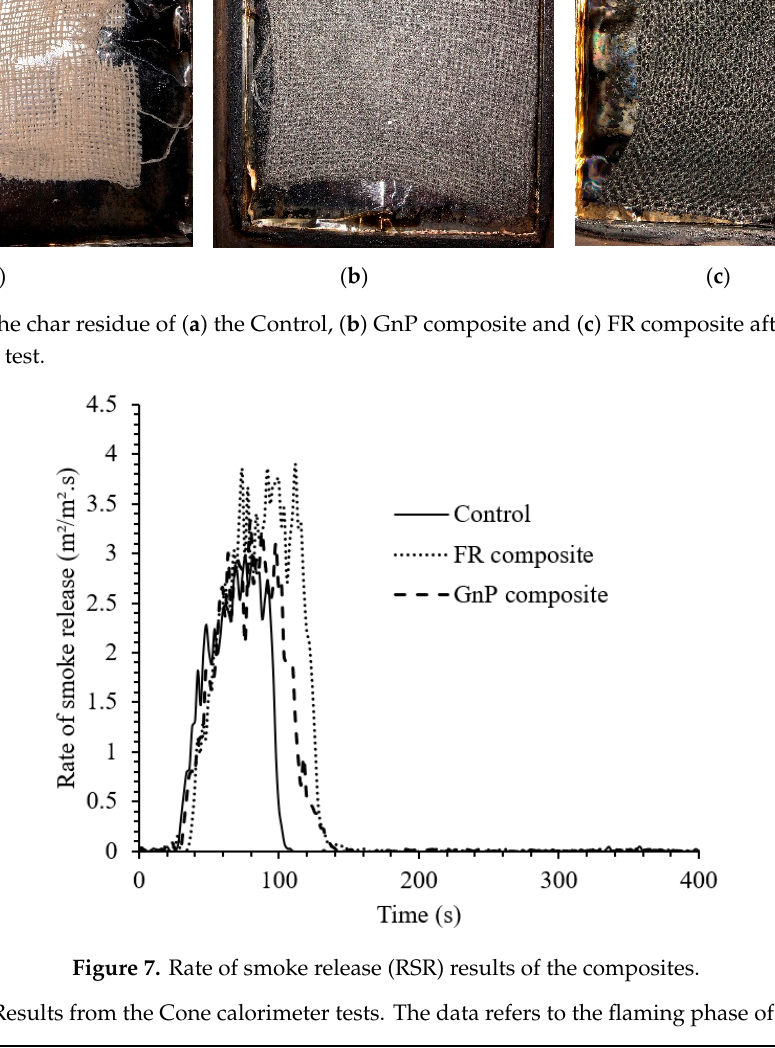
Table 3. The yields of gases evolved from the samples as determined by the FTIR. The data refers to the flaming phase of the tests.